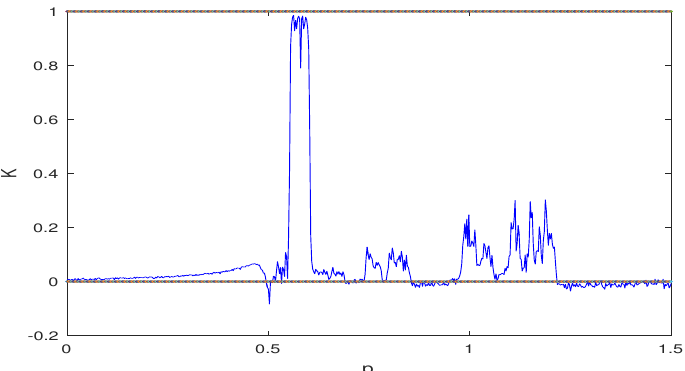
Figure 6. The 0-1 test versus P of the D.T.H.N.N with incommensurate fractional V.O (10). P = 0.1 P = 0.59